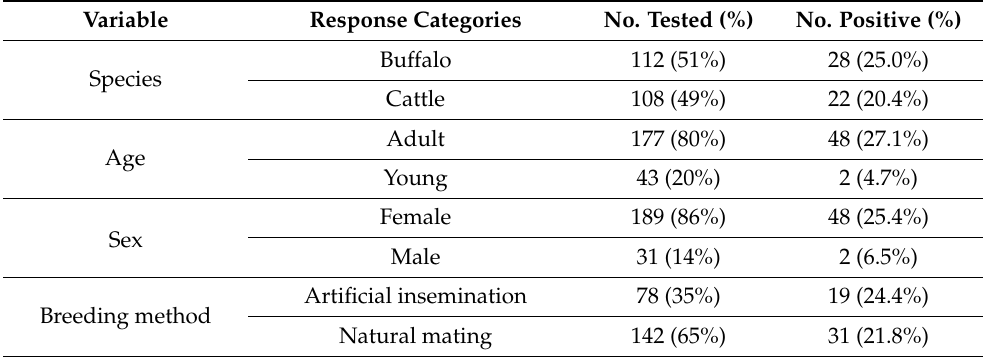
Table 2. Summary of the animal-level variables for the occurrence of brucellosis included in the initial multivariable model.